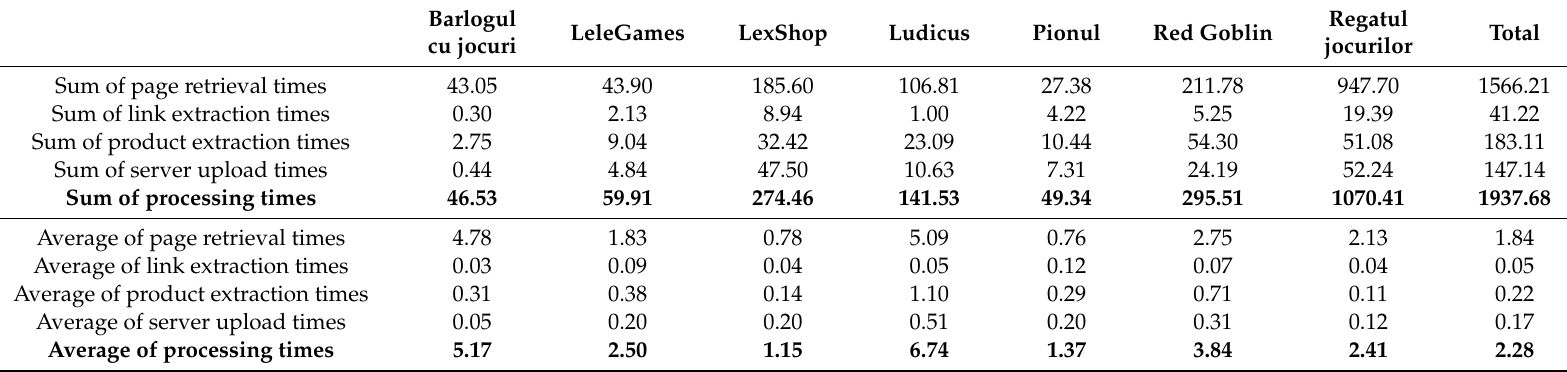
Table A1. Crawl, extraction, and processing times per page for each of seven online board game stores (expressed in seconds). The processing time (written in bold) is the sum of the page retrieval, link extraction, product extraction, and server upload times.